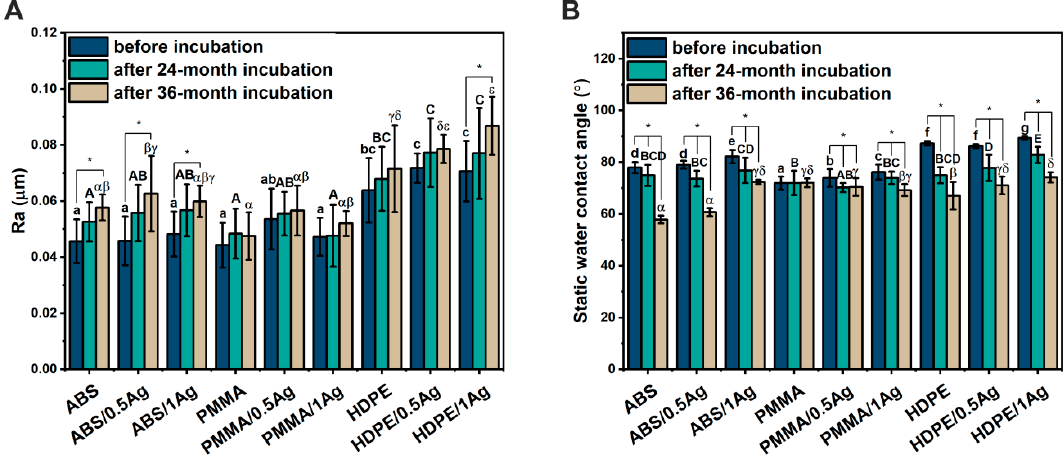
Figure 4. Arithmetical mean roughness (Ra) ( A ) and static water contact angle ( B ) of polymers and composites modified with 0.5 wt.% and 1.0 wt.% AgNPs. Statistically significant differences ( p < 0.05) between different materials before as well as after the 24- and 36-month incubation periods are indicated by subsequent lowercase and uppercase Latin letters and Greek letters, respectively. Different letters indicate statistically significant differences. Statistically significant differences ( p < 0.05) between materials before and after the 24- and 36-month incubation periods are indicated by asterisks (*). Table 1. Results of the arithmetical mean roughness of polymers and composites modified with 0.5 wt.% and 1.0 wt.% AgNPs.